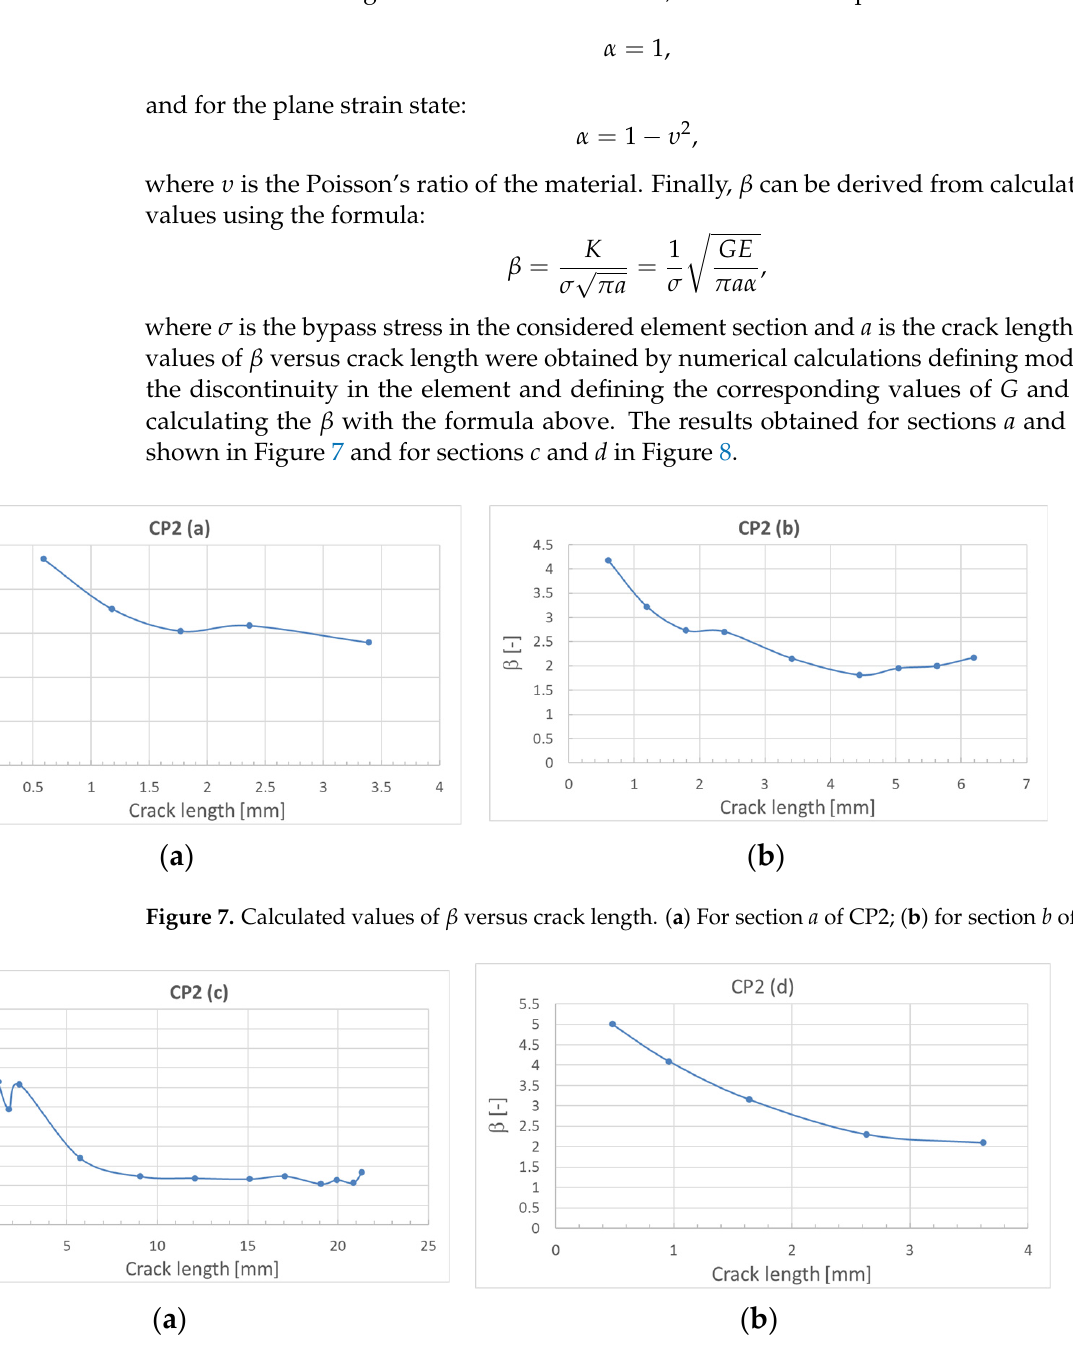
Figure 8. Calculated values of β versus crack length. ( a ) For section c of CP2; ( b ) for section d of CP2.